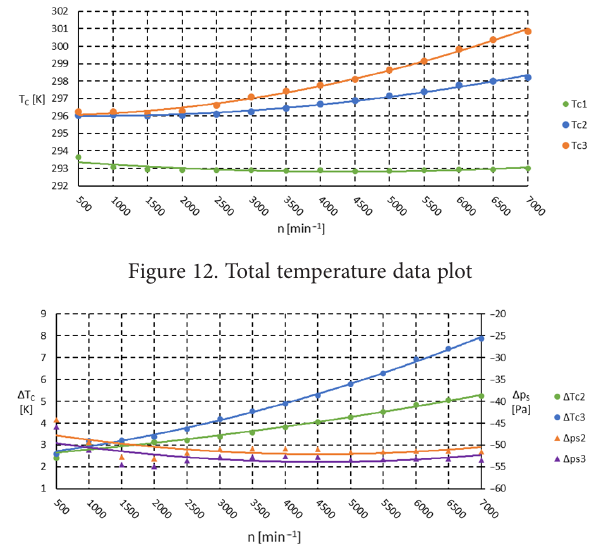
Figure 11. Measured data Gaussian distribution Figure 13. Static pressure and total temperature data